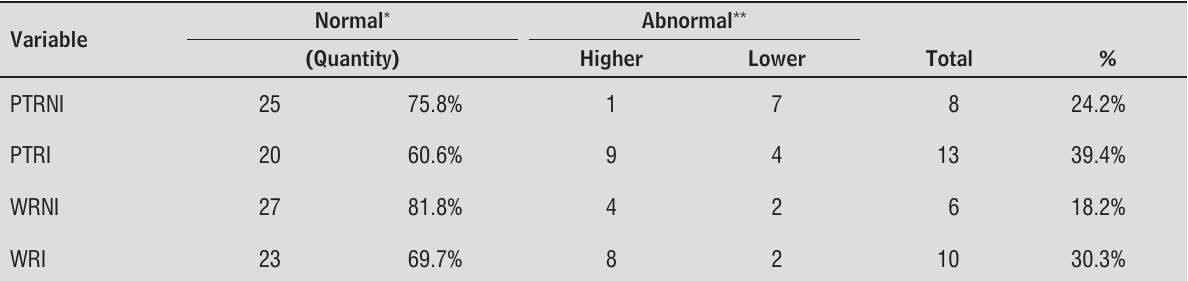
Table 2 - Distribution of cases among the variables (absolute value and percentage)